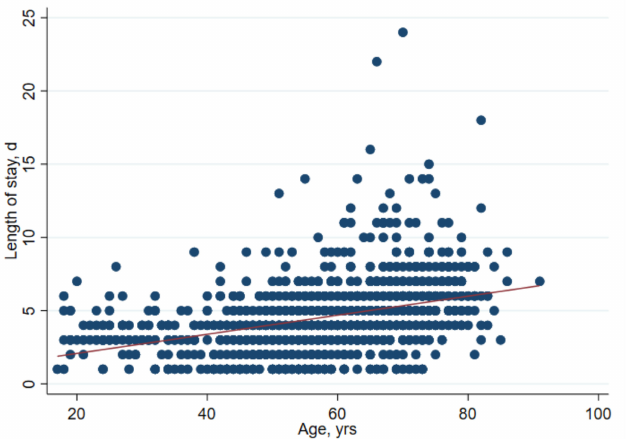
Figure 4. Correlation between age and LOS-LOS increases proportionally with age.